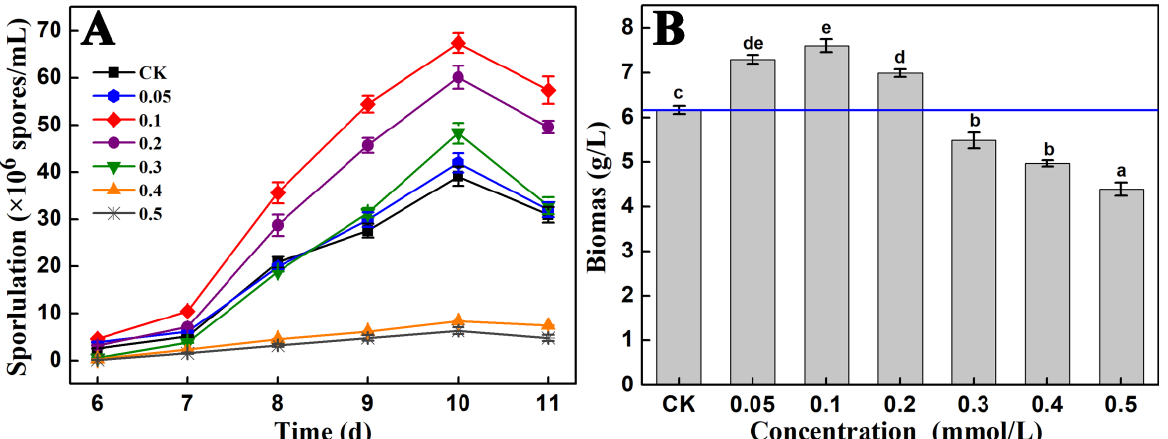
Figure 1. Effects of different concentrations of Fe 2+ on the sporulation ( A ) and biomass ( B ) of A. cinnamomea in submerged fermentation. Note: “CK”, no metal ion was added in the culture medium; “0.05”, the concentration of Fe 2+ in the culture medium is 0.05 mmol/L; “0.1, 0.2, 0.3, 0.4, and 0.5” are similar to “0.05 mmol/L Fe 2+ ”. The A. cinnamomea mycelia cultured for 10 days at 26 °C and 150 r/min with inoculum size of 1.0 × 10 6 spores/mL were used to measure the biomass; Different letters in figure B indicate significant differences at the level of 0.05 ( p < 0.05).